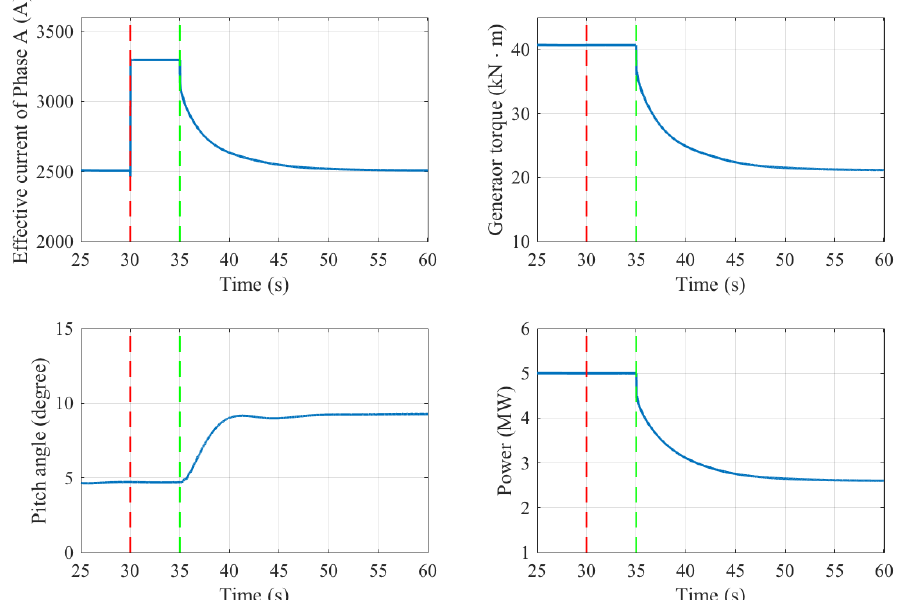
Figure 12. Waveforms of the main variables of the faulty generator.